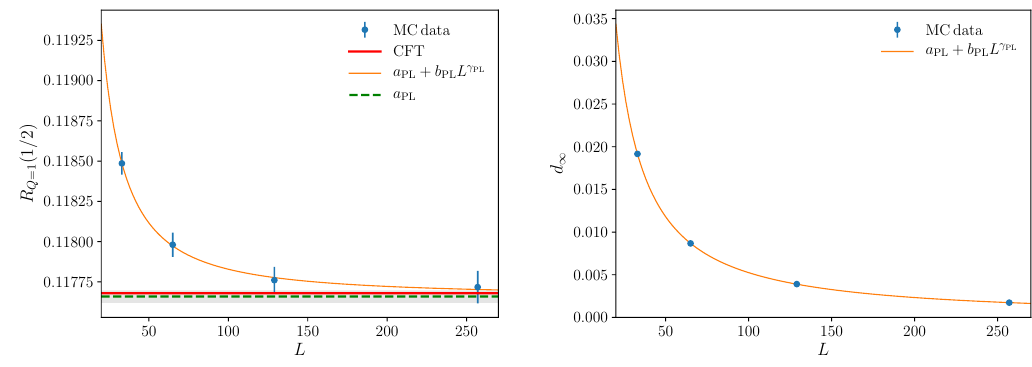
Figure 7 . (Left panel) Value of R MC a (cid:12)t with a power law model. The dotted green line is the (cid:12)tted value for a PL , with the shaded area representing the con(cid:12)dence interval. The red line is the CFT prediction. (Right panel) Distance d 1 (see eq. (5.3)) between the Monte Carlo measured R MC of L . The data can be (cid:12)tted with a power law function a PL + b PL L (cid:13) PL with a PL = (